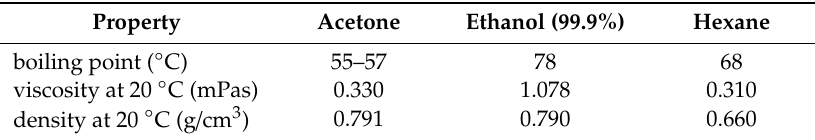
Table 1. Physical properties of solvents employed in experiments.